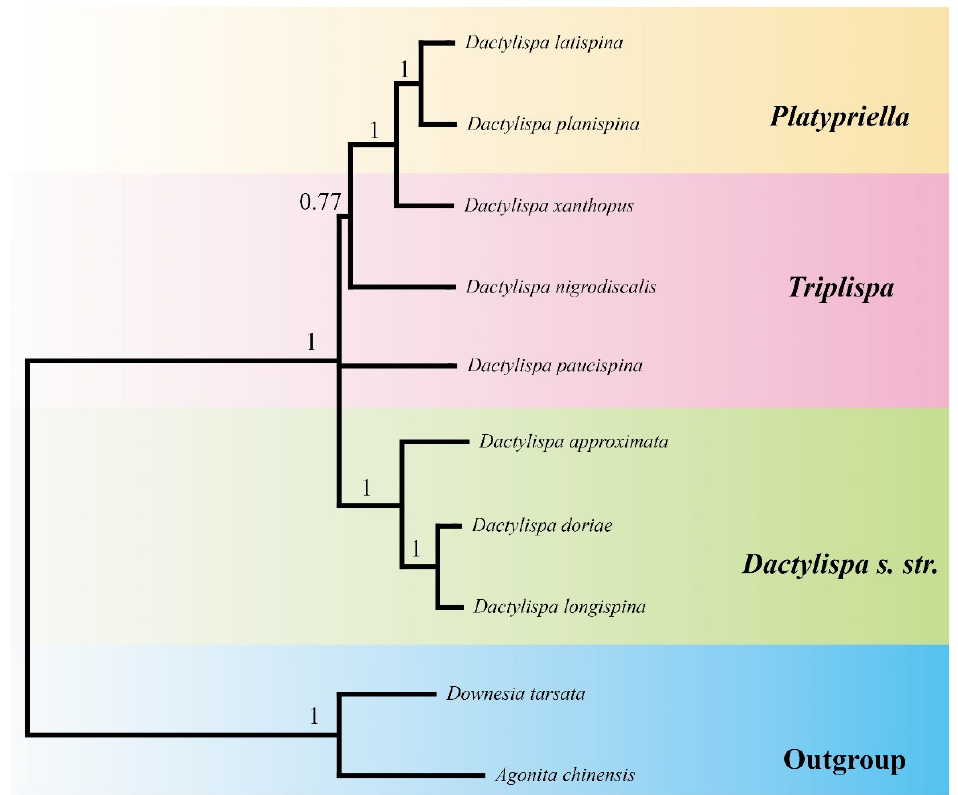
Figure 7. Phylogenetic tree of eight Dactylispa species based on complete PCG amino acids, with two Gonophorini species as the outgroup. Posterior probabilities for Bayesian inference are shown for each node.